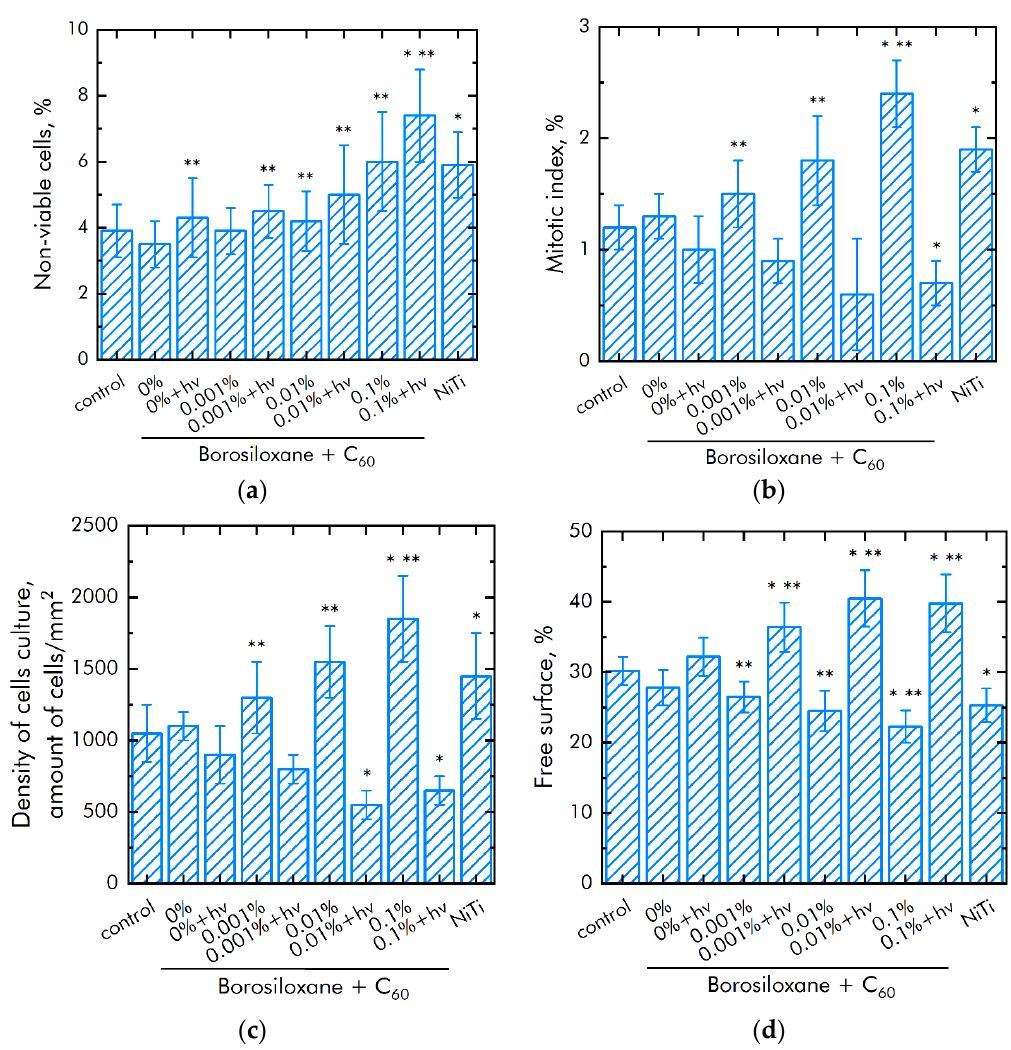
Figure 10. Effect of composite material based on borosiloxane and fullerenes on the main characteristics of cell culture growth and development: ( a ) Cell viability; ( b ) Mitotic index of a cell population; ( c ) Cell culture density; ( d ) Rate of spreading; * indicates a significant difference at 5% level in comparison with the control ( p <0.05). ** indicates a significant difference at 5% level in comparison with the NiTi group ( p <0.05). Data are presented as mean values and standard errors.